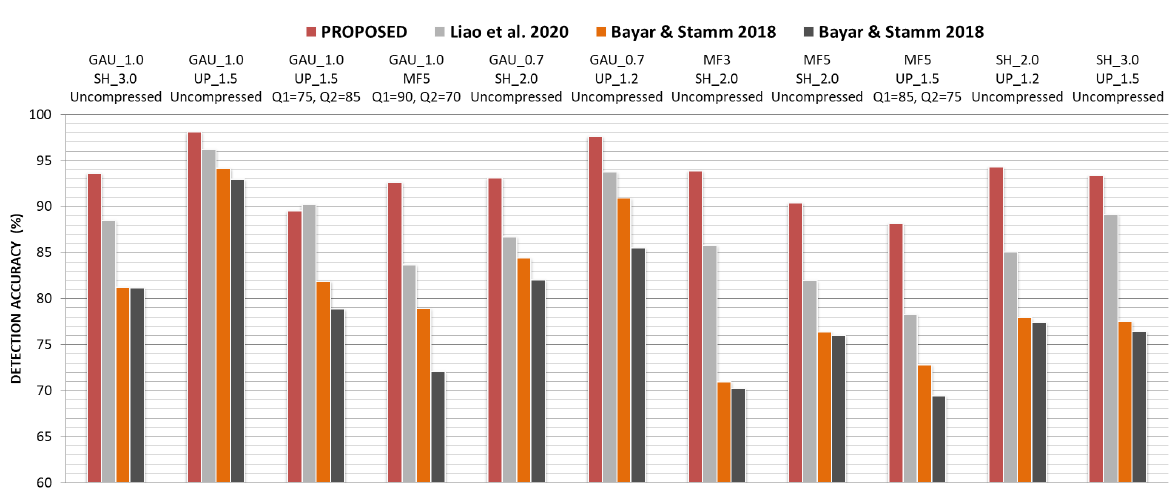
Figure 13. Comparative analysis in multiple scenarios.